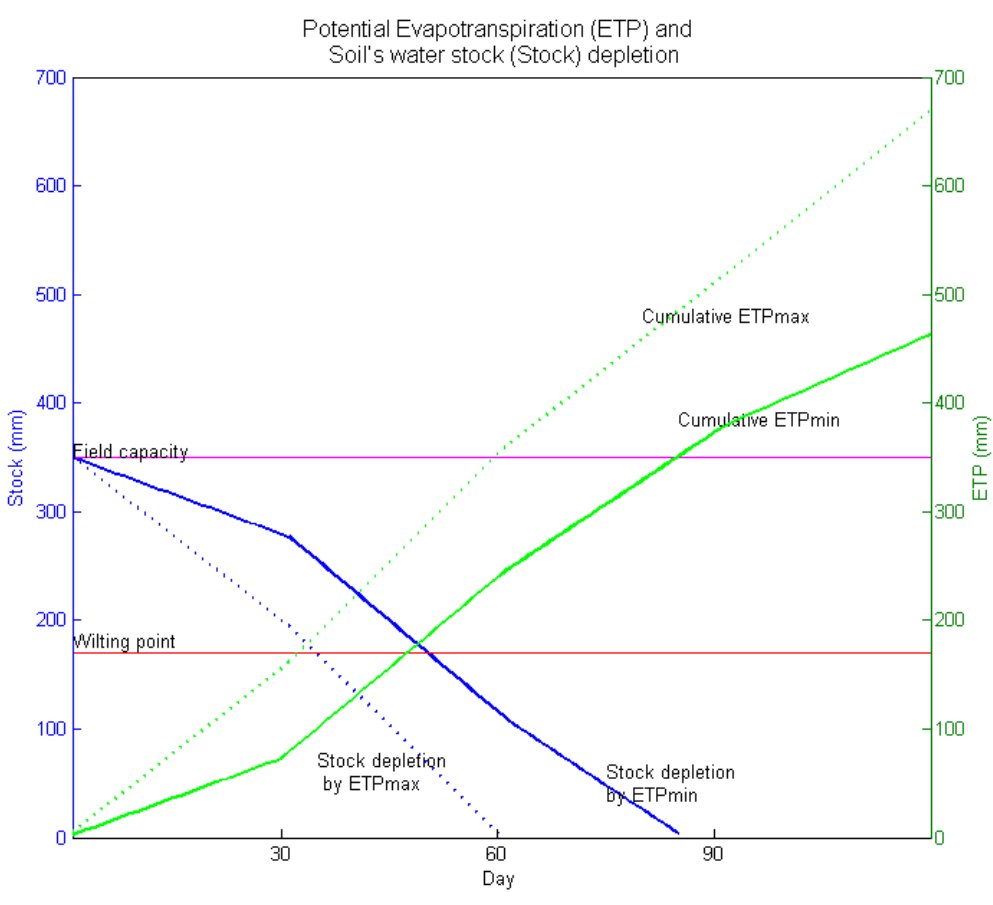
Figure 12. Simulation of potential evapotranspiration (ETP) and soil’s water stock depletion for a hypothetical sorghum crop.